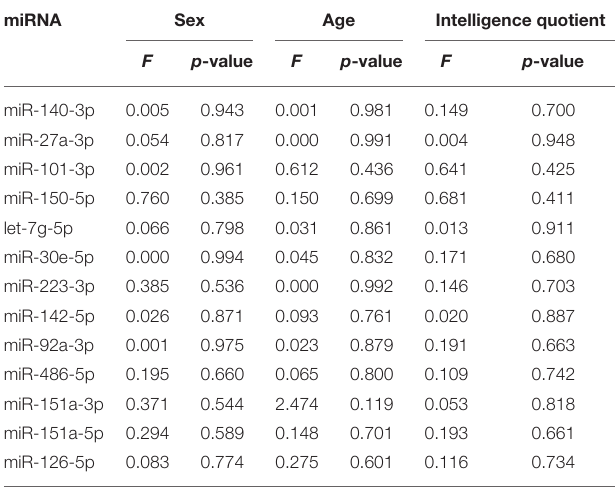
TABLE 2 | Effects of sex, age, and intelligence quotient on miRNA expression in the Training Set. miRNA Sex